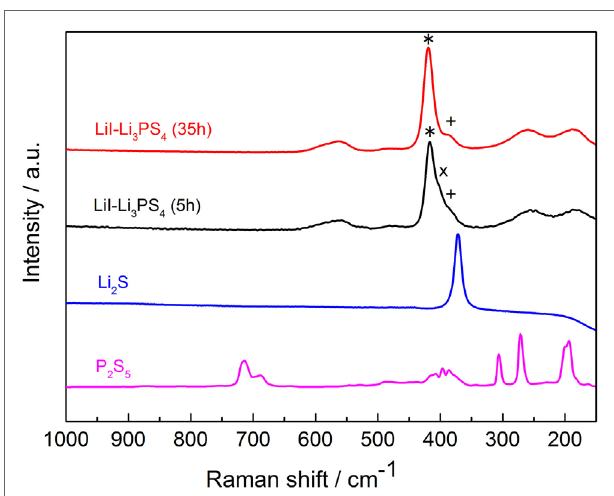
FigUre 1 | raman spectra of the starting materials and the solid-state electrolyte, lii–li 3 Ps 4 after ball milling for 5 h (black) and